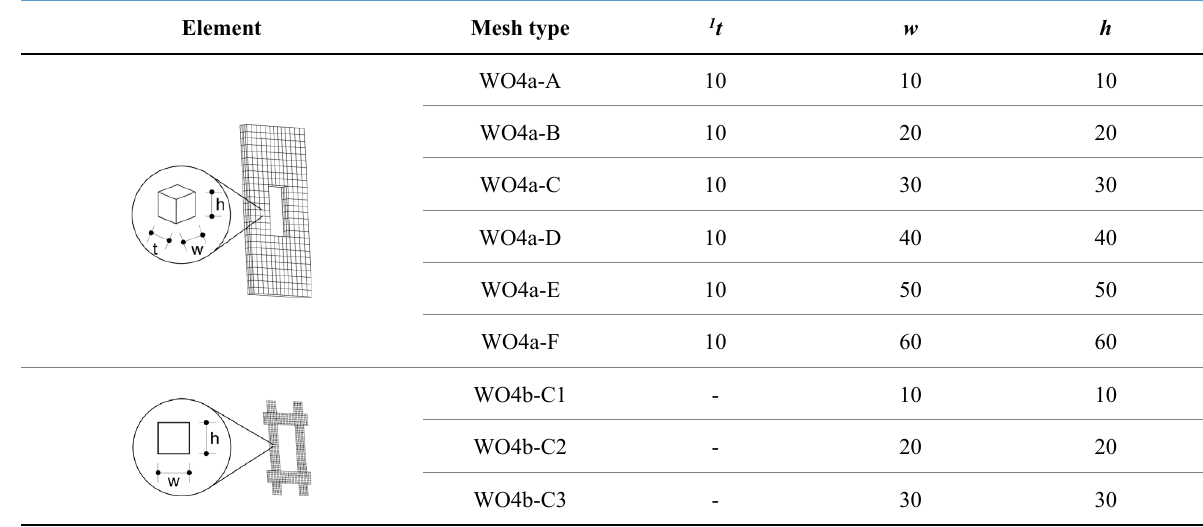
Table 2. Finite element model meshes.